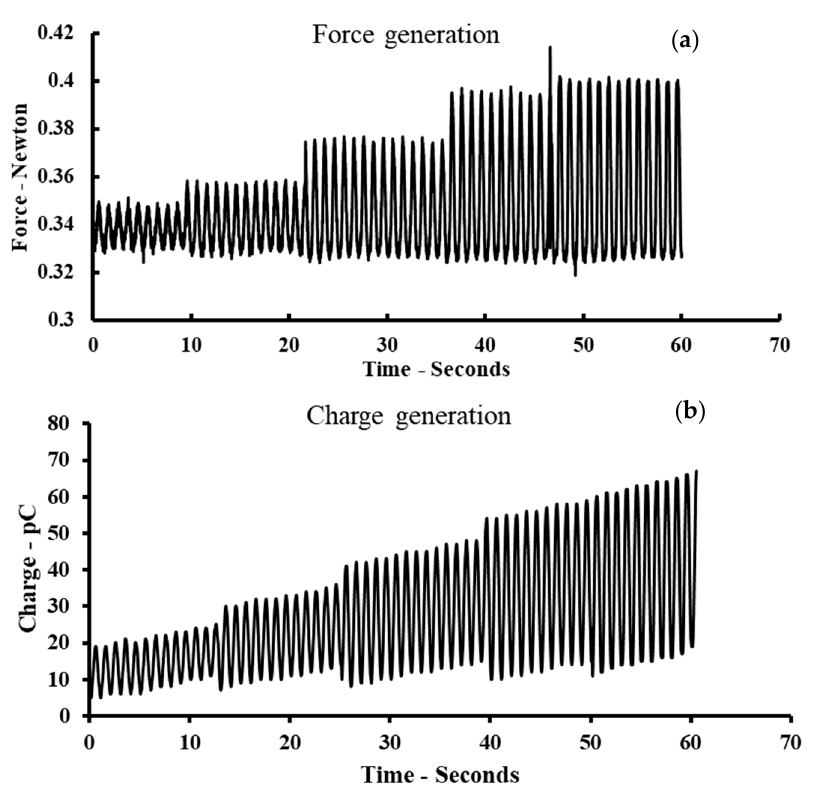
Figure 9. The force applied ( a ) by a sine shape form along the fiber axes and ( b ) charge generation in time domain.